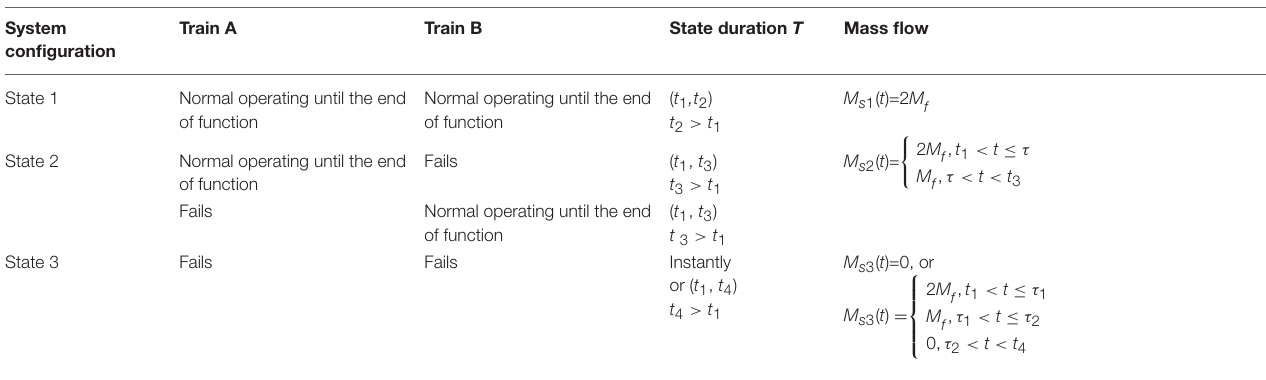
TABLE 6 | State definition by available trains of